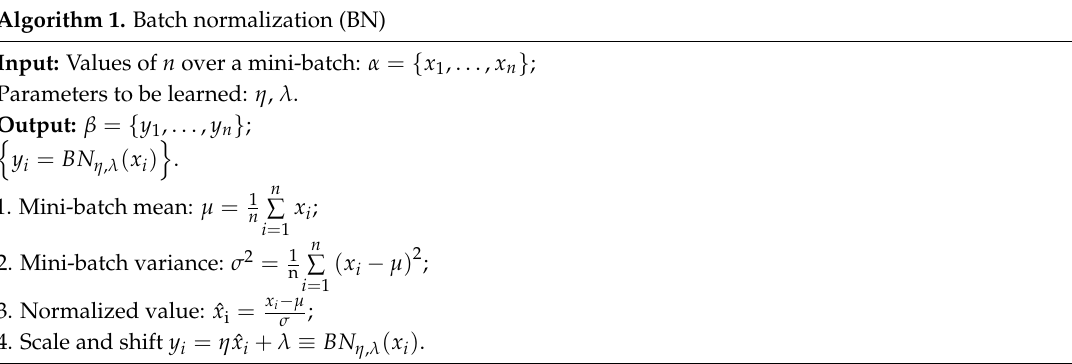
Algorithm 1. Batch normalization (BN)